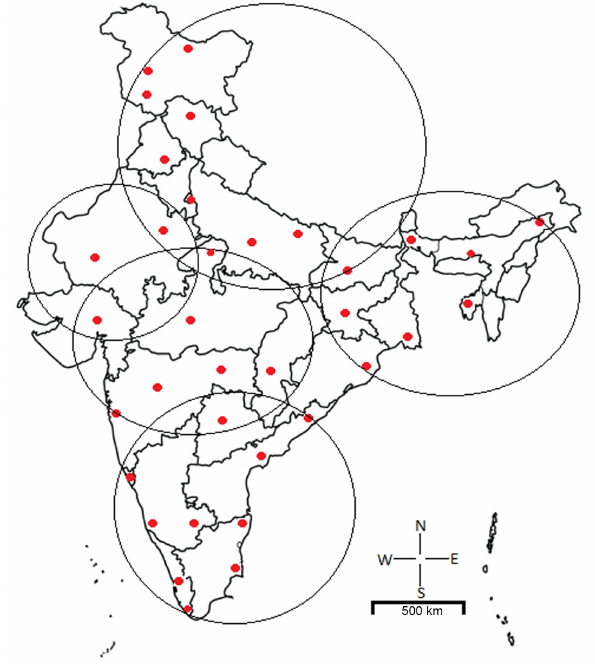
Figure 2. Radiosonde stations (red dots) of IMD over India. Areas marked with ellipses represent different